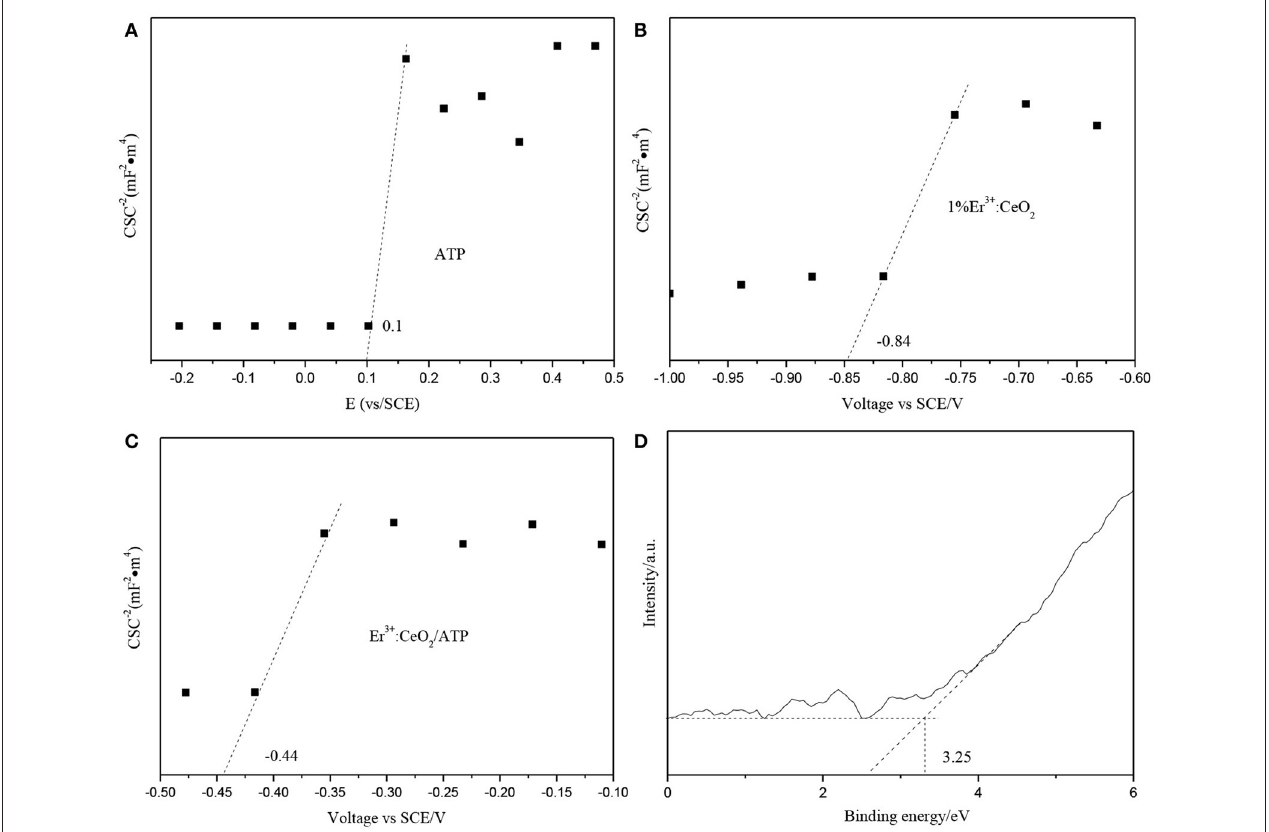
FIGURE 10 | Mott-schottky patterns of ATP (A) , 1%Er 3 + :CeO 2 (B) , 1%Er 3 + :CeO 2 /ATP (4:10) (C) , and VB-XPS pattern of ATP (D) .